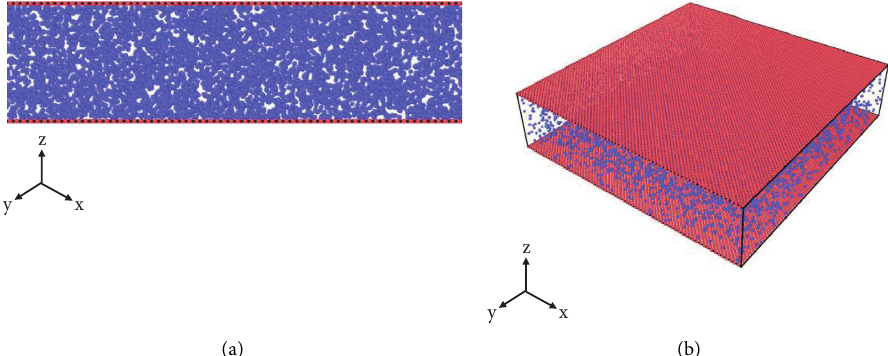
Figure 3: Snapshots of methane in slit nanopore (blue: methane atoms, red: C atoms). (a) Slit pore model profile. (b) Slit pore model 3D